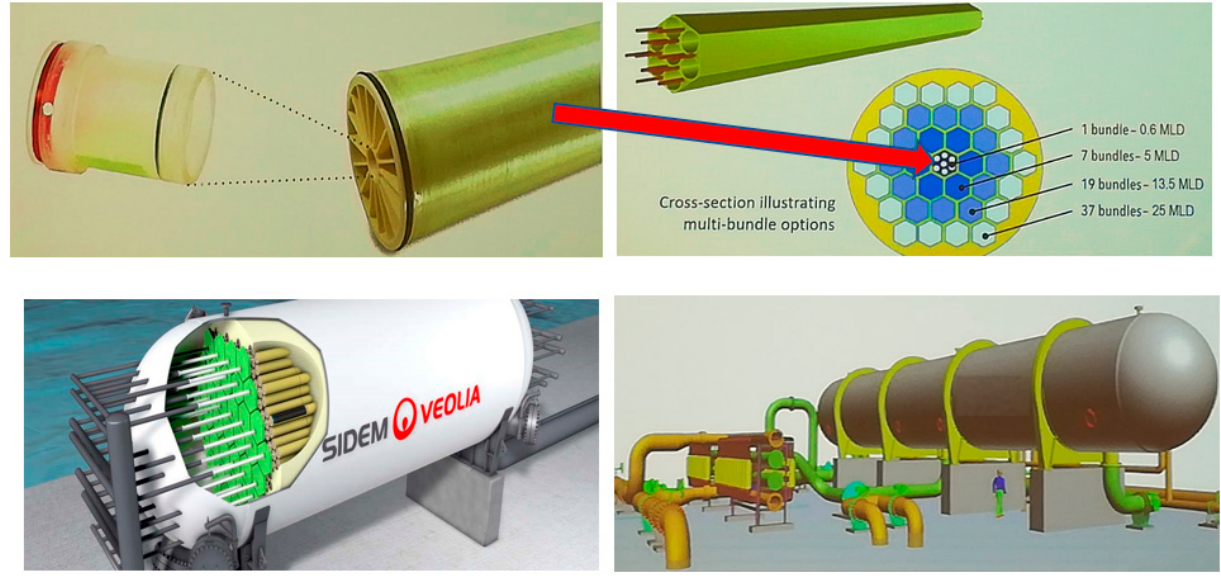
Figure 15. A huge “Barrel installation of RO plant” (lower right pic—showing comparison with a human body) with smart sensor (left upper pic) able to disable a defective module. Designed by Veolia [45].